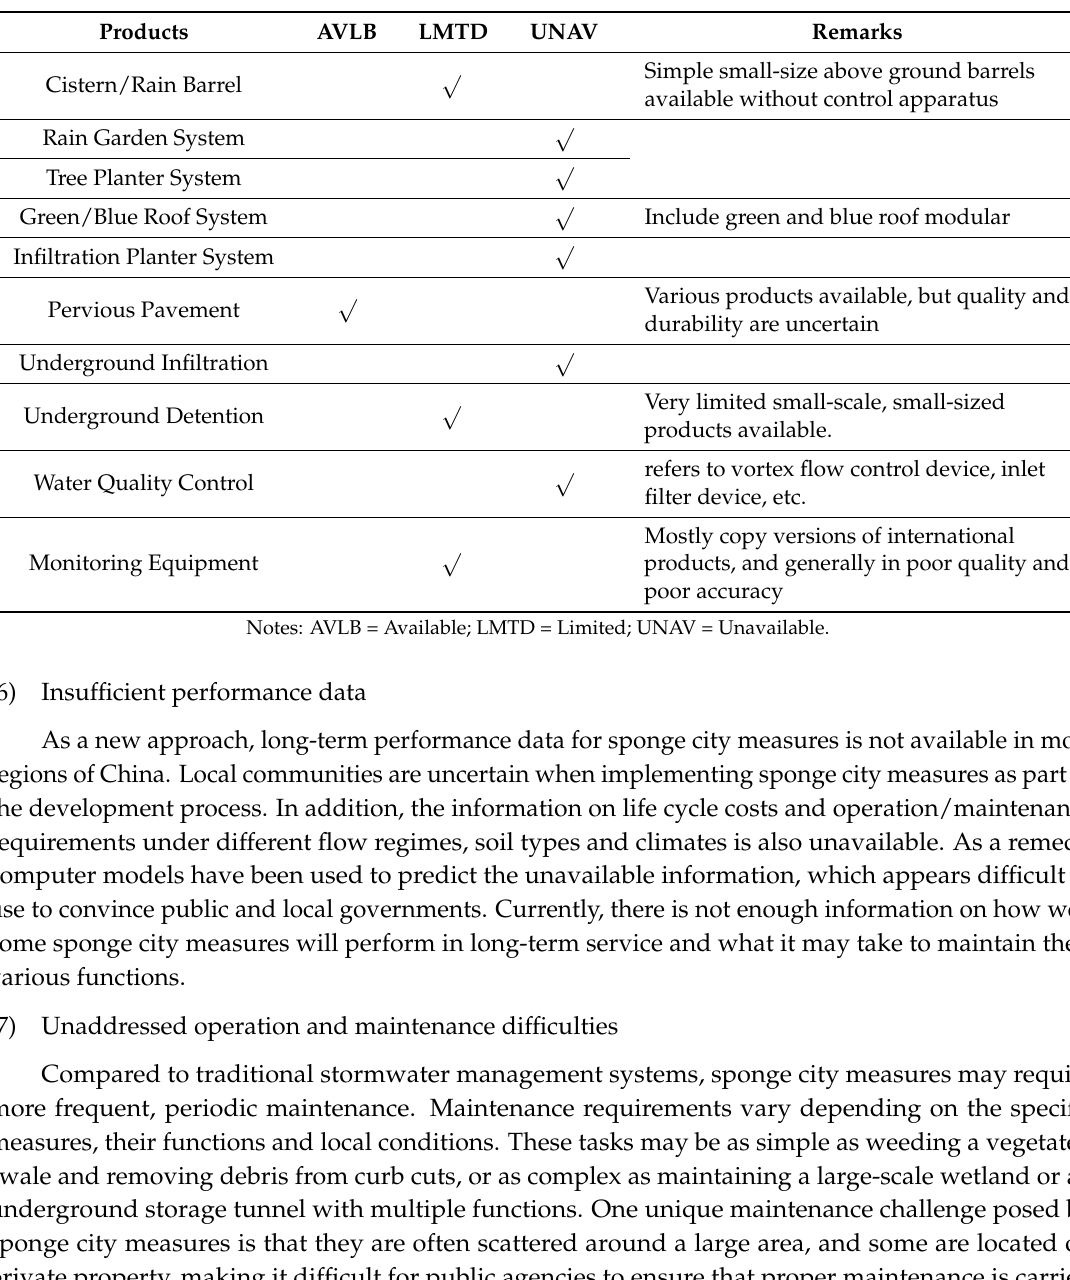
Table 3. Availability of various green infrastructure